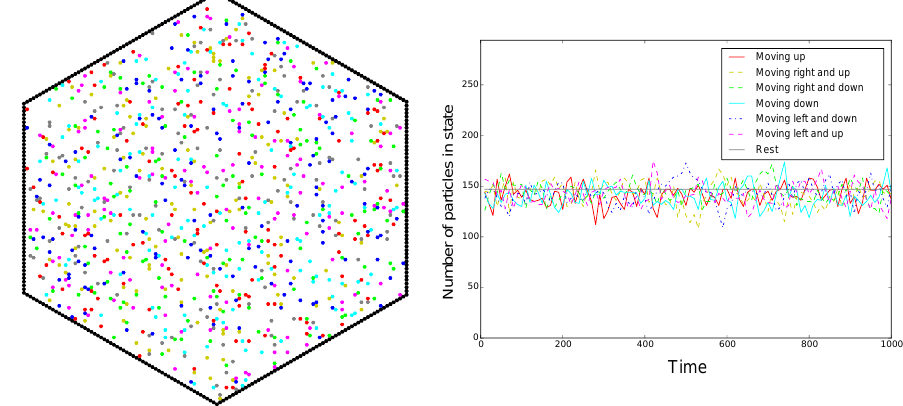
Figure 12. Example of a CTS lattice gas model. Left: particles undergoing random (brownian) motion in a vessel. Color codes: white is empty, black is wall, and gray is resting; others moving in the directions indicated in inset legend. Right: number of particles in each movement direction versus time, illustrating the conservation of average momentum.